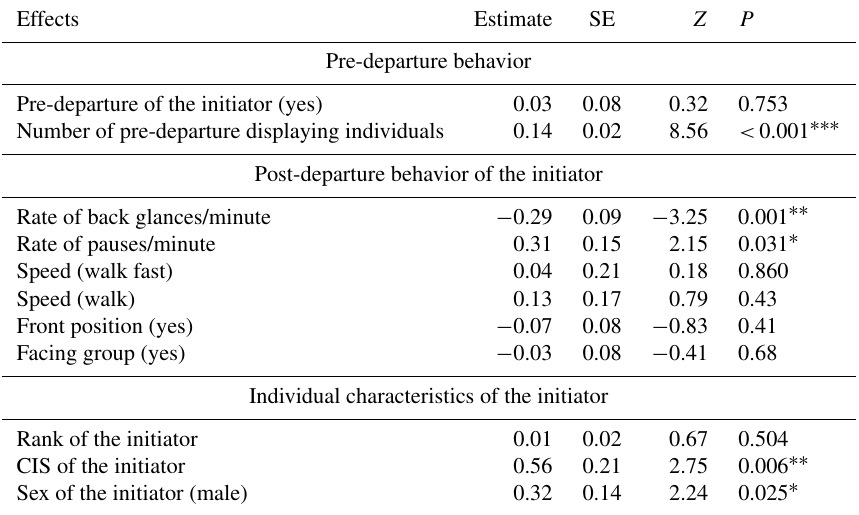
Table 2. Effect of predictor variables on the number of followers in initiation movements ( N = 283), SE – standard error, ∗ P < 0.05, ∗∗ P < 0.01 and ∗∗∗ P <